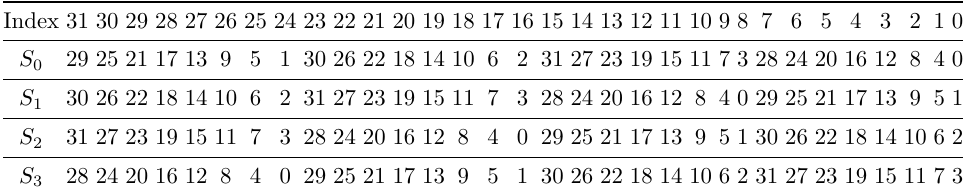
Table 9: Bit-sliced GIFT ∗ permutation where index 0 is the rightmost bit of a row segment. Following the notation by SUNDAE-GIFT proposal, the bit identified by j moves to the its new position denoted in S i after application of the permutation [BBP +